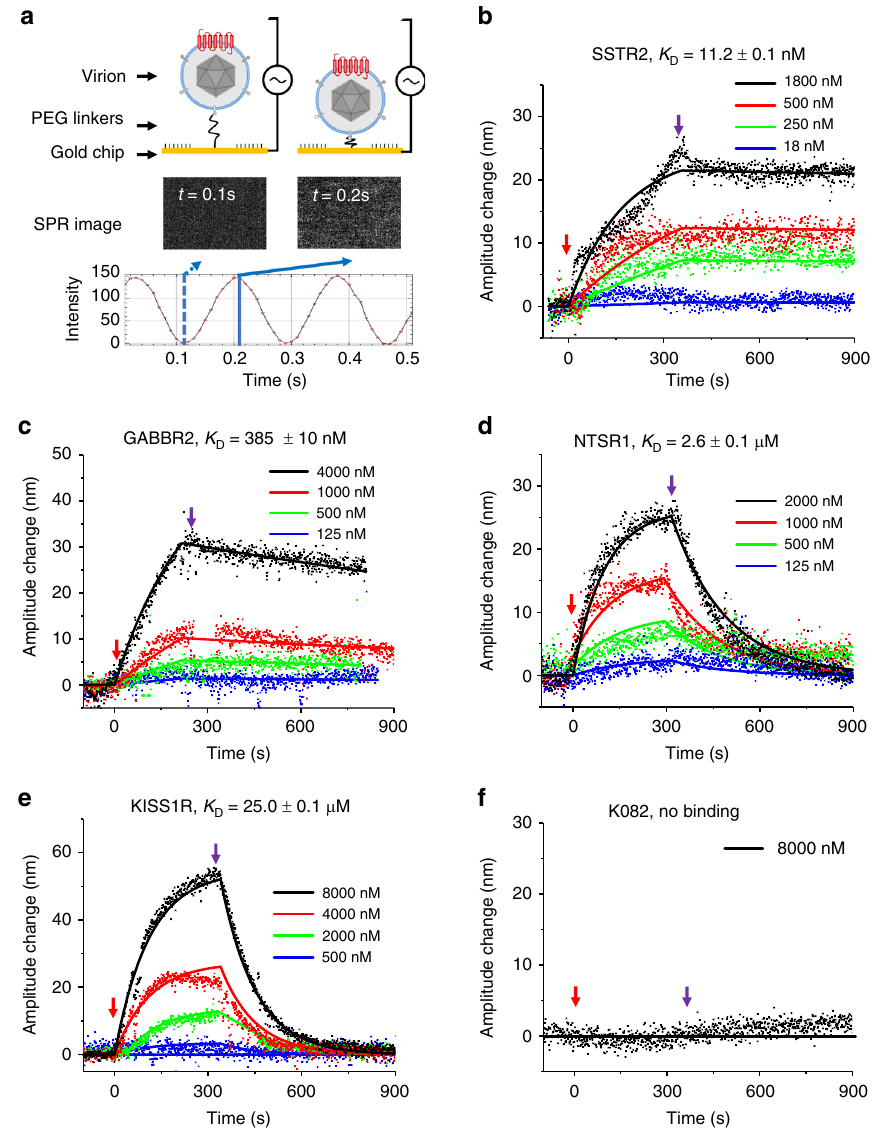
Fig. 4 Binding kinetics of SRIF-14 to SSTR2, K082, and other three virions. a Principle of binding kinetics measurement using virion-oscillator device. b – f Binding kinetics of SRIF-14 to its canonical receptor, SSTR2, and three newly discovered off-target GPCRs. The red and purple arrows mark the starting time points of the association and the dissociation phases, respectively. Binding curves were fi t using the fi rst order kinetics model (solid lines). The calculated af fi nity values range from 11.2 nM (SSTR2) to 25.0 µ M (KISS1R), while K082 virion showed no detectable binding activity to the SRIF-14. Detailed k a , k d , and K D values are listed in Supplementary Table